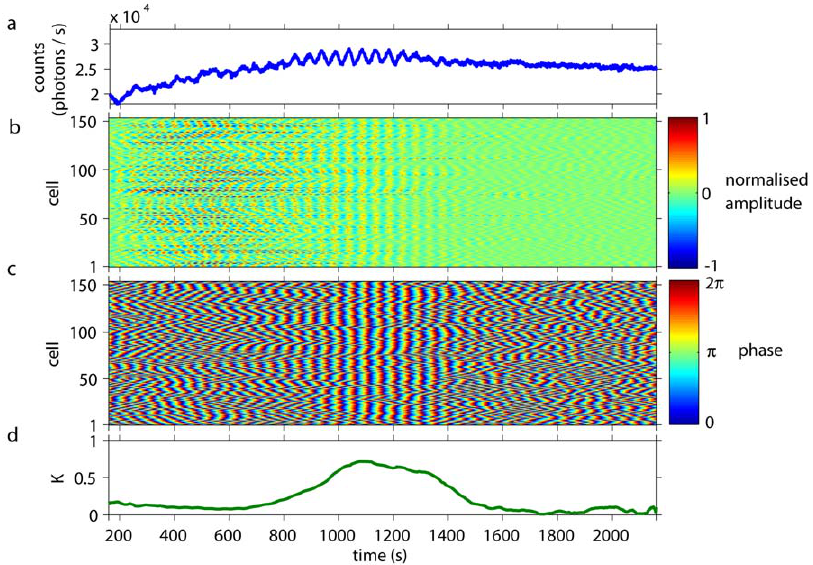
Figure 4. Collective and individual dynamics of S.carlsbergensis at a cell density of 0.1%. At t =0 an aliquot of 52 mM glucose was added to the starved and immobilised cells. (a) The time-series of the macroscopic, collective fluorescence signal is quiescent. At t =850 s a transient episode of synchronised, collective oscillations sets in. After 1350 s, the collective signal becomes quiescent again. (b) The individual cells remain oscillatory during the entire duration of the experiment. Remarkably, the synchronisation episode sets in as the normalised amplitudes of the glycolytic oscillations already diminishes. (The amplitude of the oscillations of the cells corresponds to 45–95 photons/s.) The cells are numbered in an random order. (c) At the begin and end of the experiment, the individual cells oscillate at their own periods and phases. The synchronisation episode at 850 s ƒ t ƒ 1350 s is caused by a temporary entrainment of the oscillations of the individual cells. (d) The time-dependent Kuramoto order parameter reflects the dynamics in the cell population. It remains below * 0.3 as the cells oscillate in a incoherent manner, and increases to levels of K * 0.7 during the synchronisation episode.